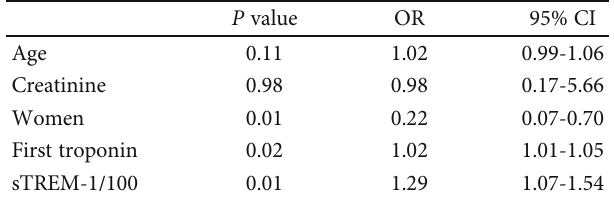
Table 5: Logistic regression for developing ACS compared to noncardiac chest